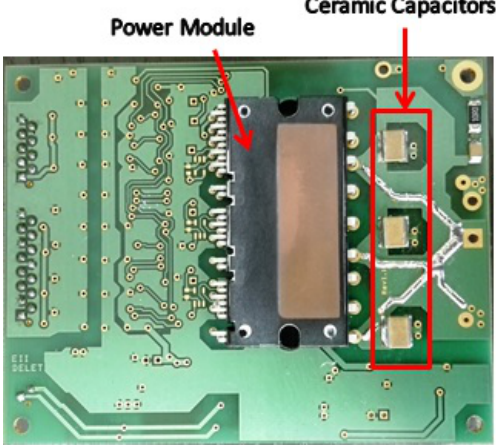
Figure 16. 3-phase module: in the picture, the Intelligent Power Module (IPM) and the ceramic capacitors introduced in order to reduce the commutation path are